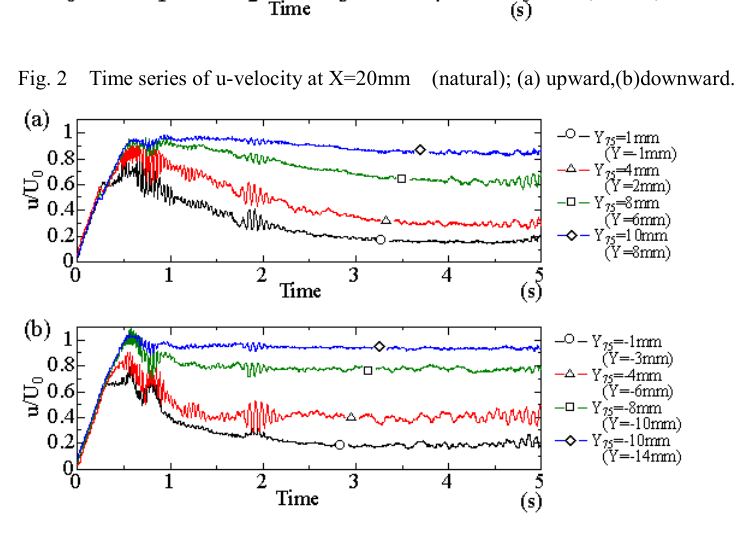
Fig. 3 Time sries of u-velocity at X=75mm (natural); (a)upward, (b)downward.